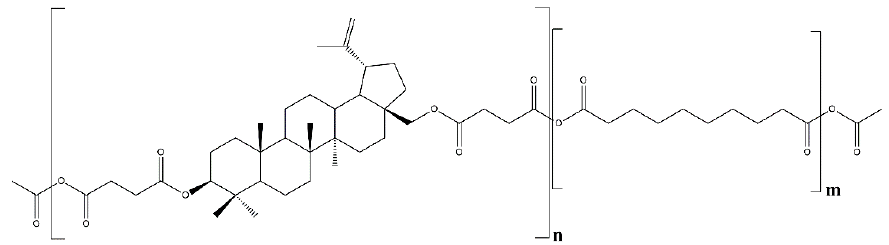
Figure 1. Structure of polyDBB_SEB.